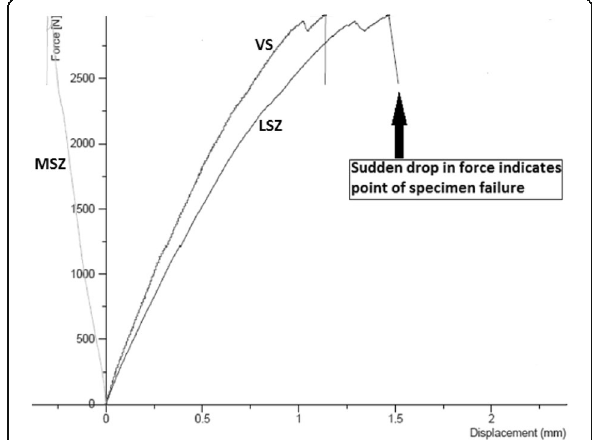
Fig. 5 Graph showing example of vertical displacements. “ VS ” is positive, indicating the downward vertical motion of the piston. “ MSZ ” is negative and “ LSZ ” is positive, indicating a valgus malrotation of the tibial